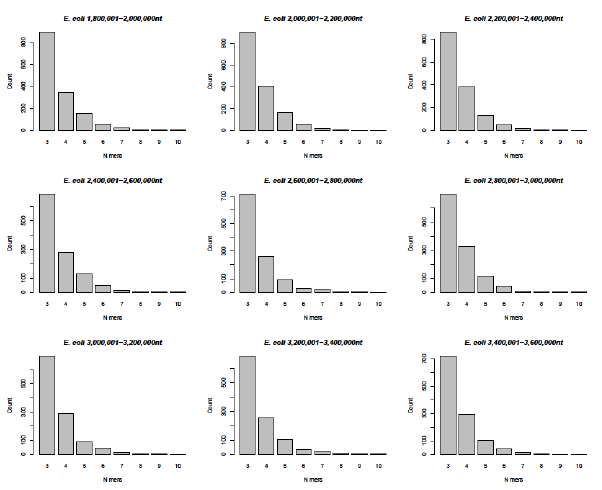
Figure 5. Histograms of nucleotide sequence identities between the SARS-CoV-2 genome and dif- ferent segments of the entire Escherichia (E) coli K12 DNA as indicated in individual panels. For details of the programmed analyses of the entire E. coli K12 genome see Materials and Methods. Very similar data obtained for the E. coli DNA segments 1 to 1.8 million and 3,400,001 to 4,641,652 have been deposited under Supplemental Materials (Figure